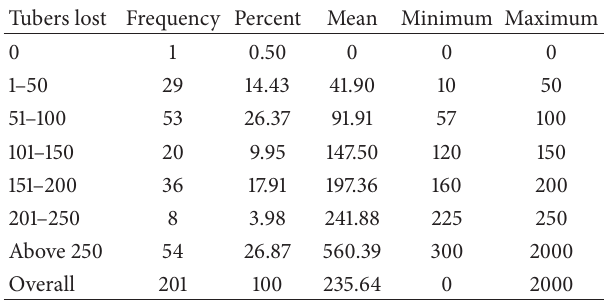
Table 2: Distribution of yam postharvest losses for 2013/2014 production